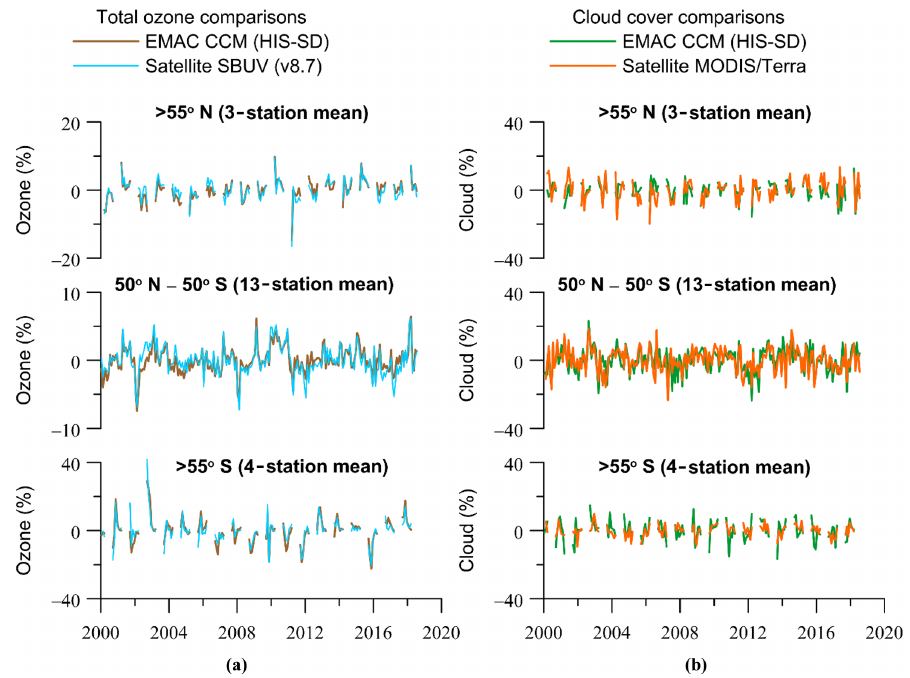
Figure 3. (a) Same as in Fig. 1 but for ozone column. (b) For cloud cover. The y axes show monthly de-seasonalized anomalies (in %) relative to the long-term monthly mean (2000–2018). Shown are monthly anomalies from March to September for the northern high latitudes and from September to March for the southern high latitudes. For 50 ◦ N–50 ◦ S, we present all